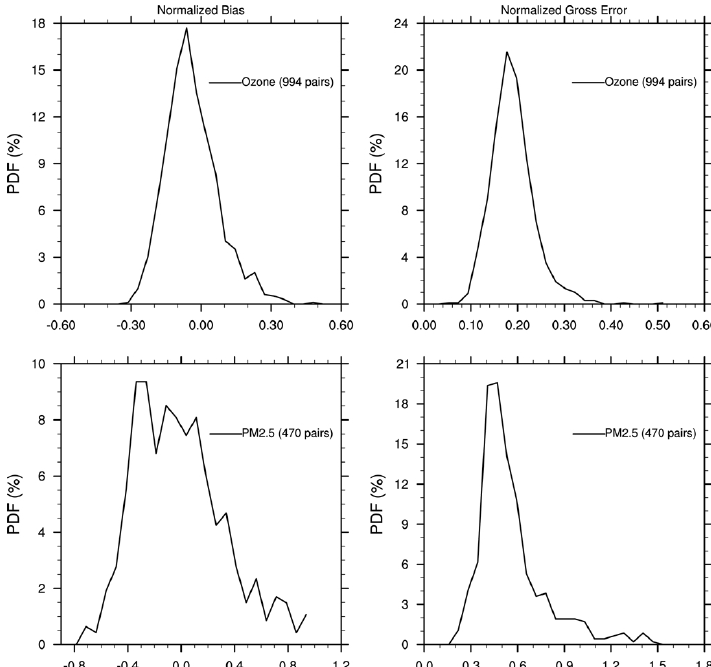
Fig. 2. Probability distributions of NB and NGE from individual site for the E